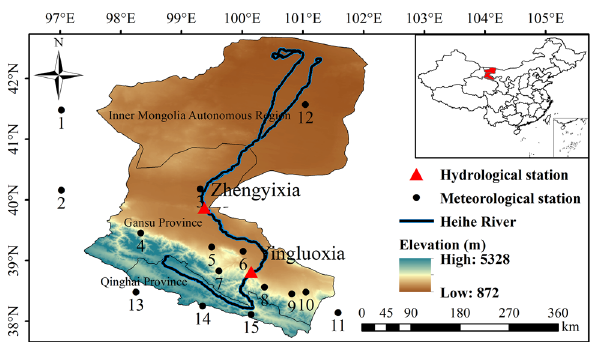
Fig. 1 Meteorological and hydrological stations in the Heihe River Basin, China. River basin upper reaches: Mountain pass to Yinglu- oxia. River basin middle reaches: Yingluoxia to Zhengyixia. River basin lower reaches: Area north of Zhengyixia. 1. Mazongshan; 2. Yumenzhen; 3. Dingxin; 4. Jiuquan; 5. Gaotai; 6. Linze; 7. Sunan; 8. Zhangye; 9. Minle; 10. Shandan; 11. Yongchang; 12. Ejinaqi; 13. Tuolei; 14. Yeniugou; 15.